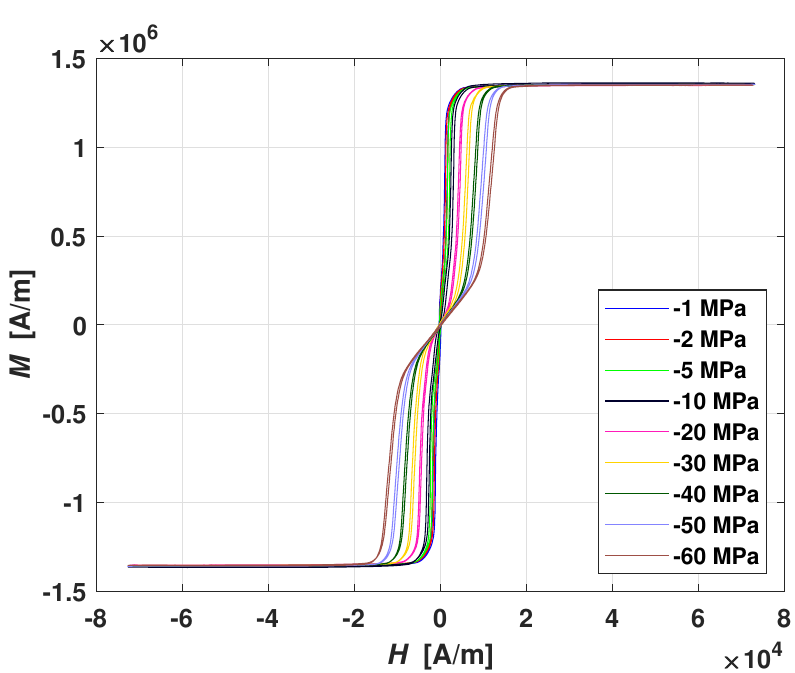
Figure 1. Experimental magnetic characteristics ( M - H ) at different applied compressive stresses σ for non-stress annealed (NSA) Galfenol. These characteristics have been measured through the setup described in Section 2. More details about Galfenol are presented in Section